Question: What direction does the quantity move in — increasing or decreasing?
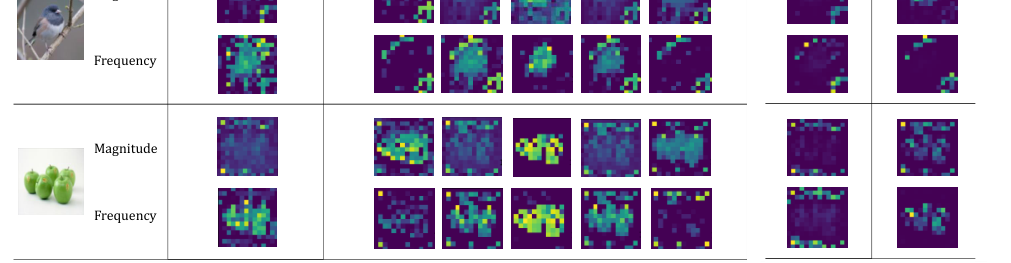
Answer: increasing